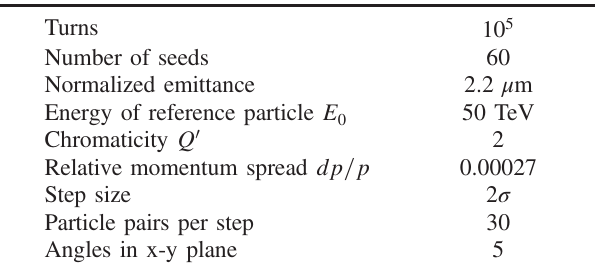
TABLE V. Parameters of the tracking